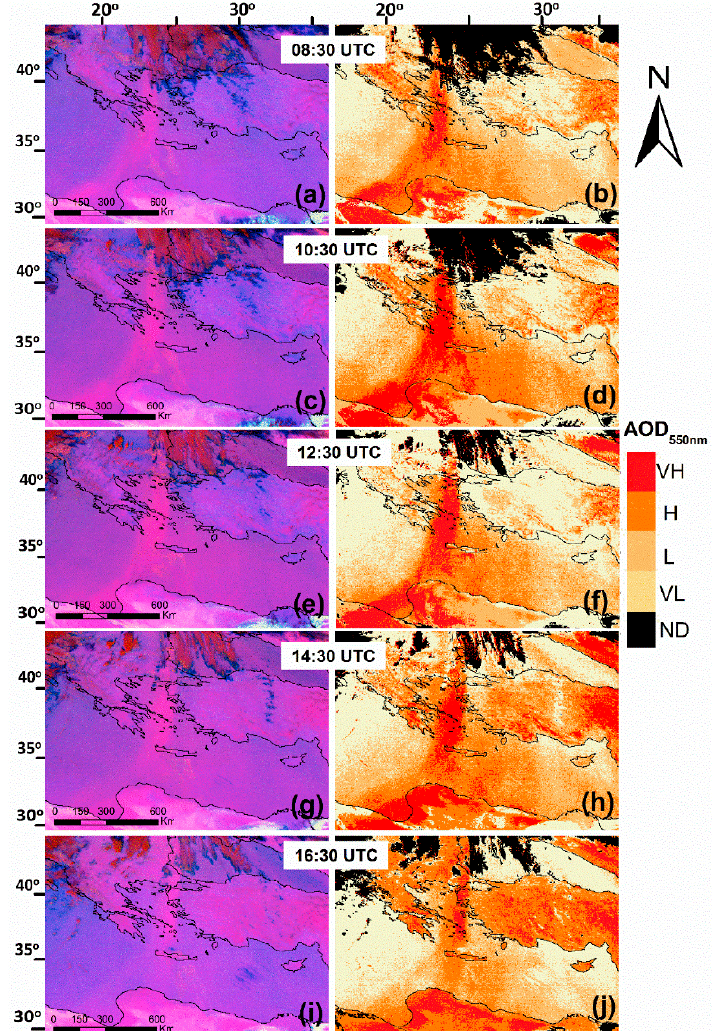
Figure 6. An African dust transport event that occurred over the Mediterranean basin on 1 March 2016. The images in magenta (RGB composites) on the left side depict dust load transportation from northern Africa up to the Aegean Sea. RGB refers to red (BTD (12.0 µ m-10.8 µ m) ), green (BTD (10.8 µ m-8.7 µ m) ), and blue (BT (10.8 µ m) µ m) channels. The right-side plots display the corresponding image products (AOD 550 nm values) of the ANN model scheme, referring to the same date / time with the RGB composites. The di ff erent colors in the right-hand plots represent four di ff erent levels of AOD 550 nm (very low—VL, low—L, high—H and very high—VH, see Section 4.1). Black colored areas correspond to optically thick cloud patterns for which aerosol loads (AOD 550 nm ) were not detected (ND) by the ANN model.